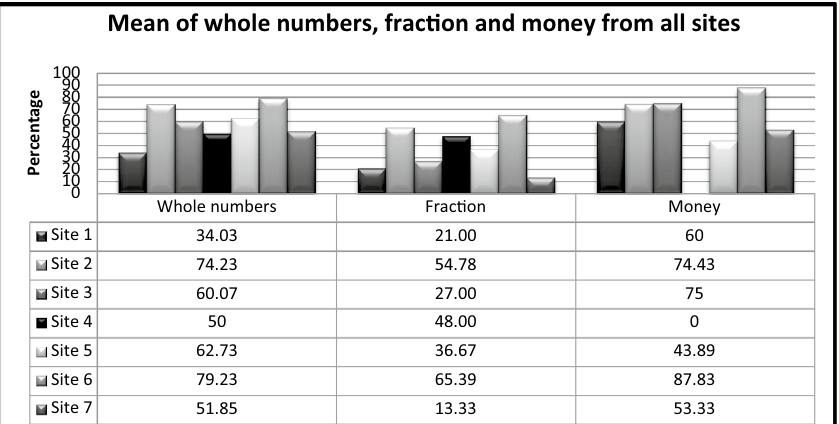
Table 1 Mean of whole numbers, fractions and money from all sites Mean of whole numbers, frac(cid:31)on and money from all